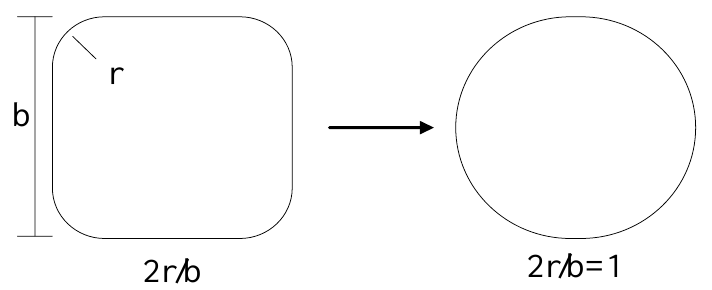
Figure 1. Transformation of uniform cross-section.